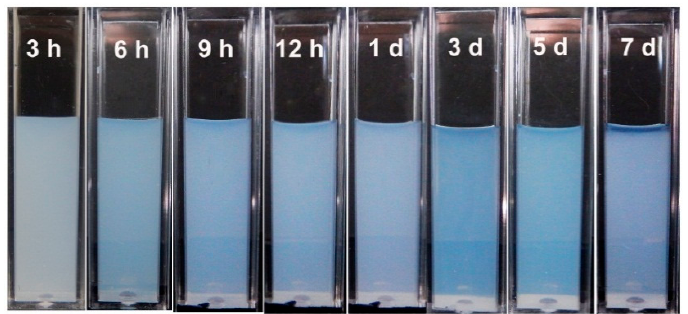
Figure 4. Photographs of Rod-CC NPs at a concentration of 1 mg/mL after standing still for 3, 6, 9, 12 h and 1, 3, 5, 7 day.